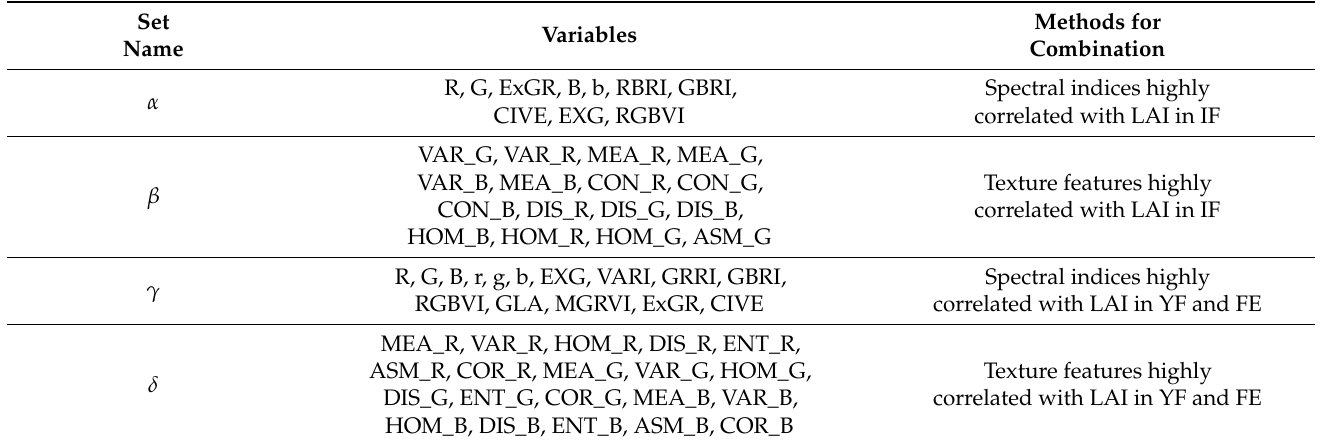
Table 4. The set of variables used in the